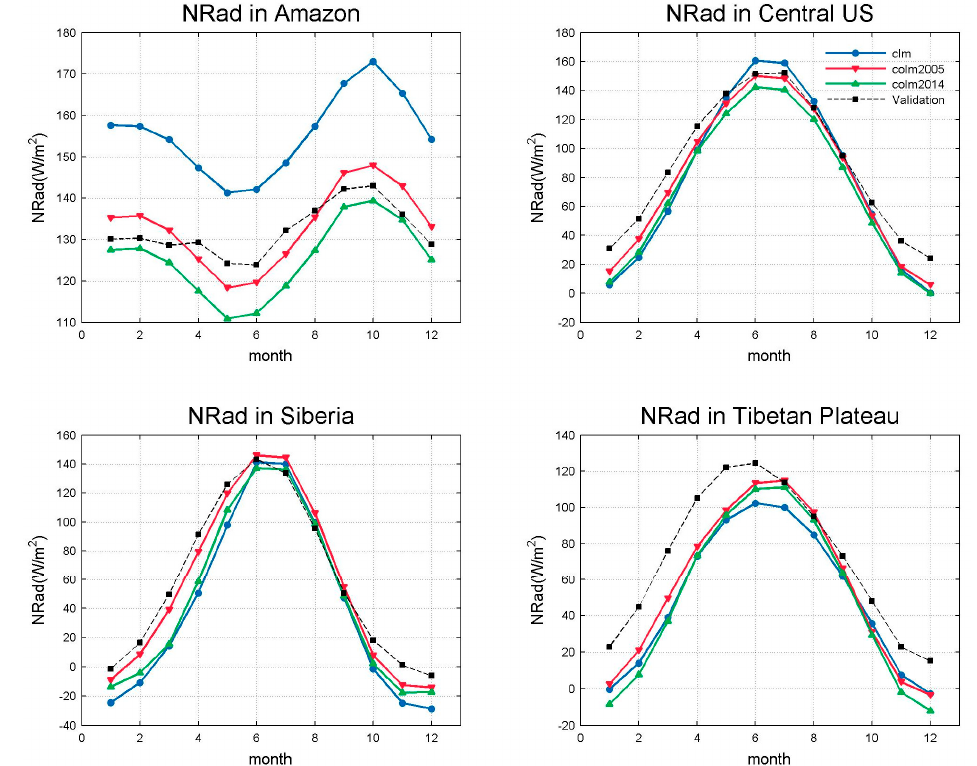
Figure 20. Same as Figure 3, but for net radiation (Units: W m − 2 ). Table 8. Statistical summary of simulated net surface radiation annual